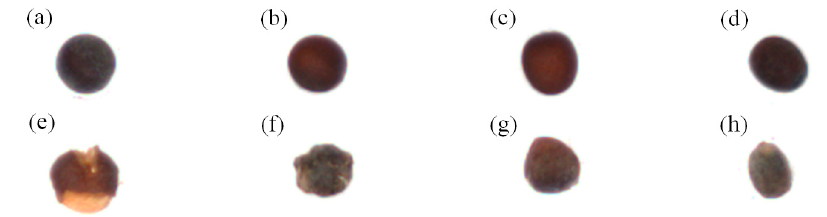
Figure 12. ( a ) Circular; ( b ) circular; ( c ) oval; ( d ) oval; ( e ) irregular; ( f ) irregular; ( g ) triangular; ( h ) elongated.